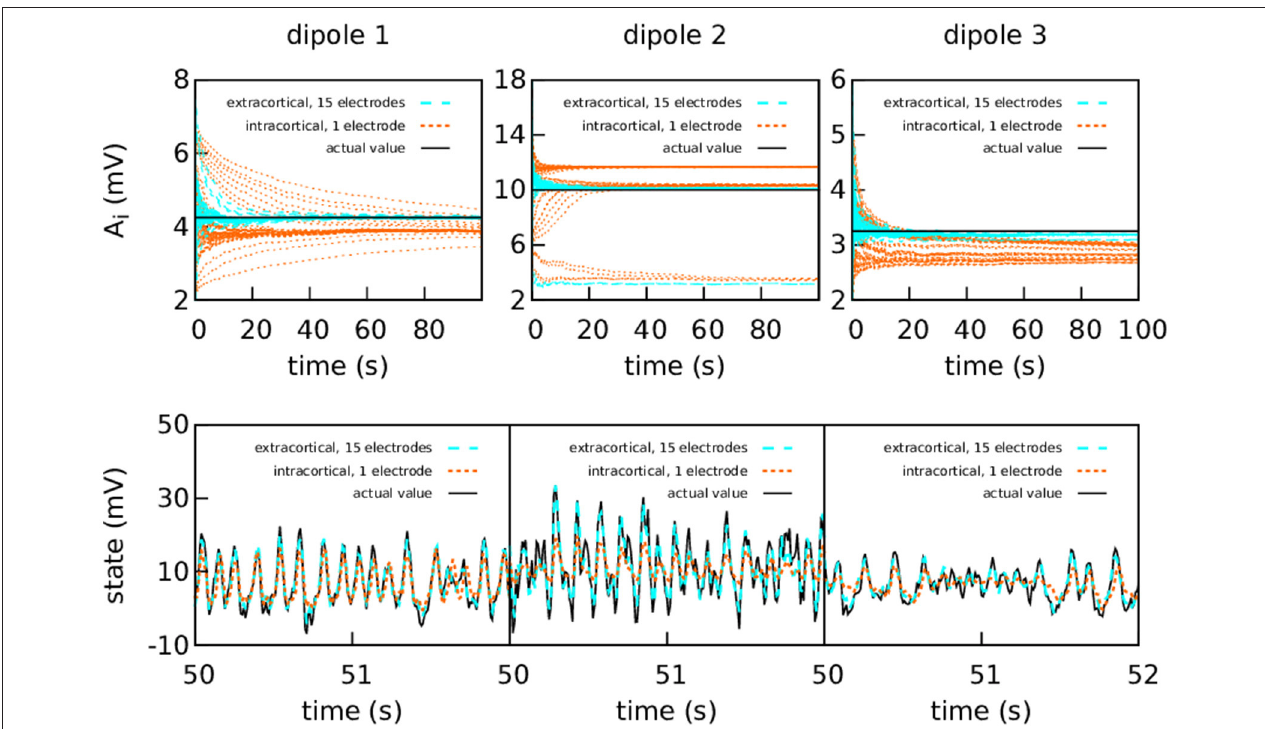
FIGURE 4 | Intracranial and extracranial fittings for coarse parameter estimation in the case of bidirectional coupling. As in the previous figure, the upper panels show the estimation of A for each cortical column and the lower show the estimations of the observed states. The results are shown here without averaging. The actual values of the amplitudes of the EPSPs are A 1 4.25 mV, A 2 10.00 mV, and A 3 3.25 mV; the rest of the parameters were set to standard values ( Table 1 ). The = = = external input p ( t ) for the three cortical columns had p 0 200 s − 1 and ǫ 100 s − 1 . The coupling constant was set to k 5. The intracortical measurements were = = = corrupted with Gaussian noise of mean 0 and standard deviation 5 mV, while the noise in the extracranial measurements has standard deviation 100 mV. Extracranial estimations of the parameters are both faster and more accurate than intracortical estimations; this applies also to the state, whose dynamics are more faithfully reproduced using multi-electrode extracranial estimation (as shown in the lower